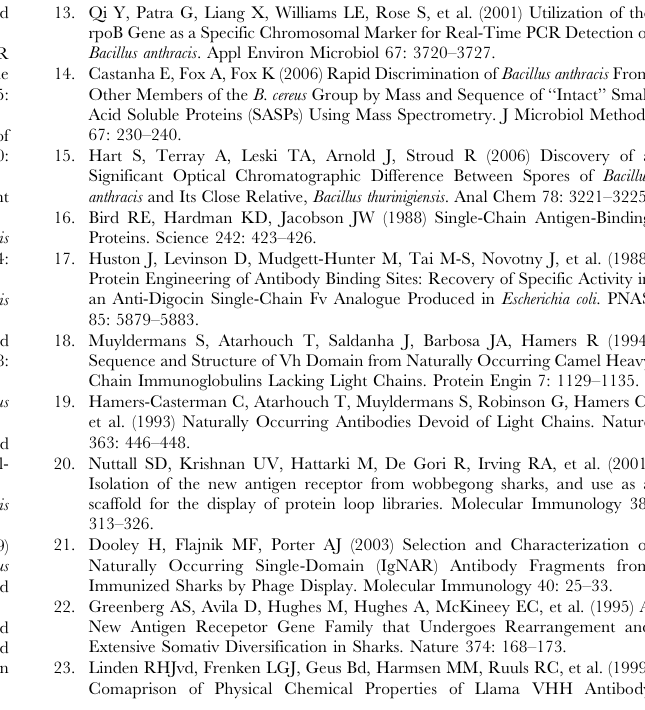
Figure S1 Purification of the S-layer protein EA-1. (A) Soluble and insoluble fractions of the cell lysate separated via SDS- PAGE for protein staining and immunoblotting (B) Chromato- graph of FPLC fractionation of soluble fraction of cell lysate (C) Gel Code Blue stained SDS-PAGE analysis of individual fractions following FPLC. Figure S2 Binding activity of sdAb following thermal denaturation and renaturation. Binding to immobilized EA1 following temperature cycling was assessed using a direct binding ELISA, SPR, and direct binding Luminex. Figure S3 Analysis of sdAb epitope. Purified sdAbs were used in a sandwich ELISA, with purified EA1 as the antigen, to ascertain whether the sdAb recognized identical epitopes. Table S1 Bacterial strains and sporulation